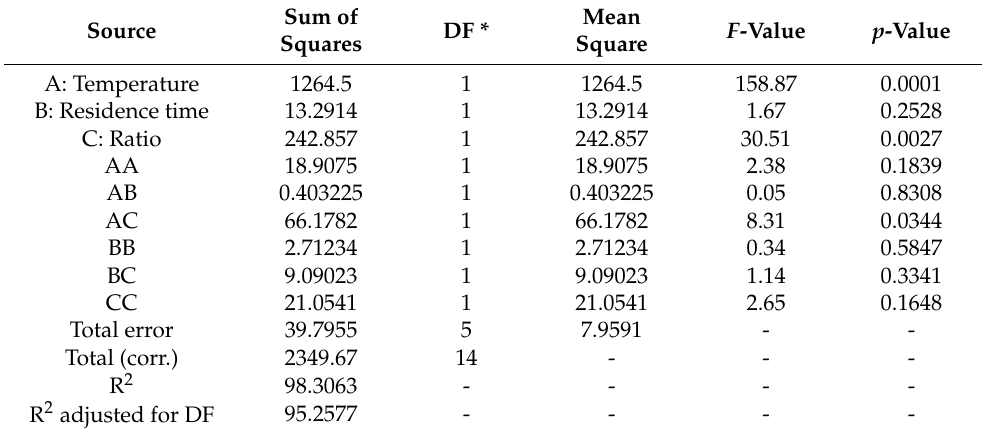
Table 4. ANOVA results for Li yield from the 3 3 Box-Behnken design with three central points.